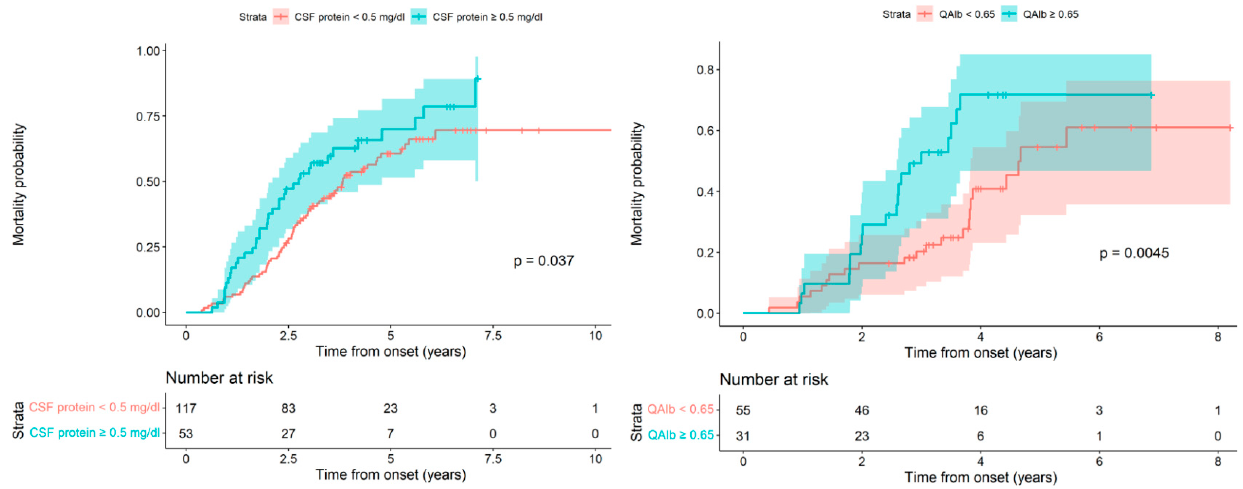
Figure 3. ( Left ) Mortality probability as a function of the follow-up time from onset when comparing levels of CSF proteins using 0.5 g/L as a cut-off point for those with a spinal phenotype. We observed an increased probability of death in patients with CSF protein ≥ 0.5 g/L when compared to those with CSF protein < 0.5 g/L ( Right ). Mortality probability as a function of the follow-up time from onset comparing the two QAlb levels for the spinal phenotype. We observed an increased probability of death in patients with QAlb ≥ 0.65 compared to those with QAlb <0.65.